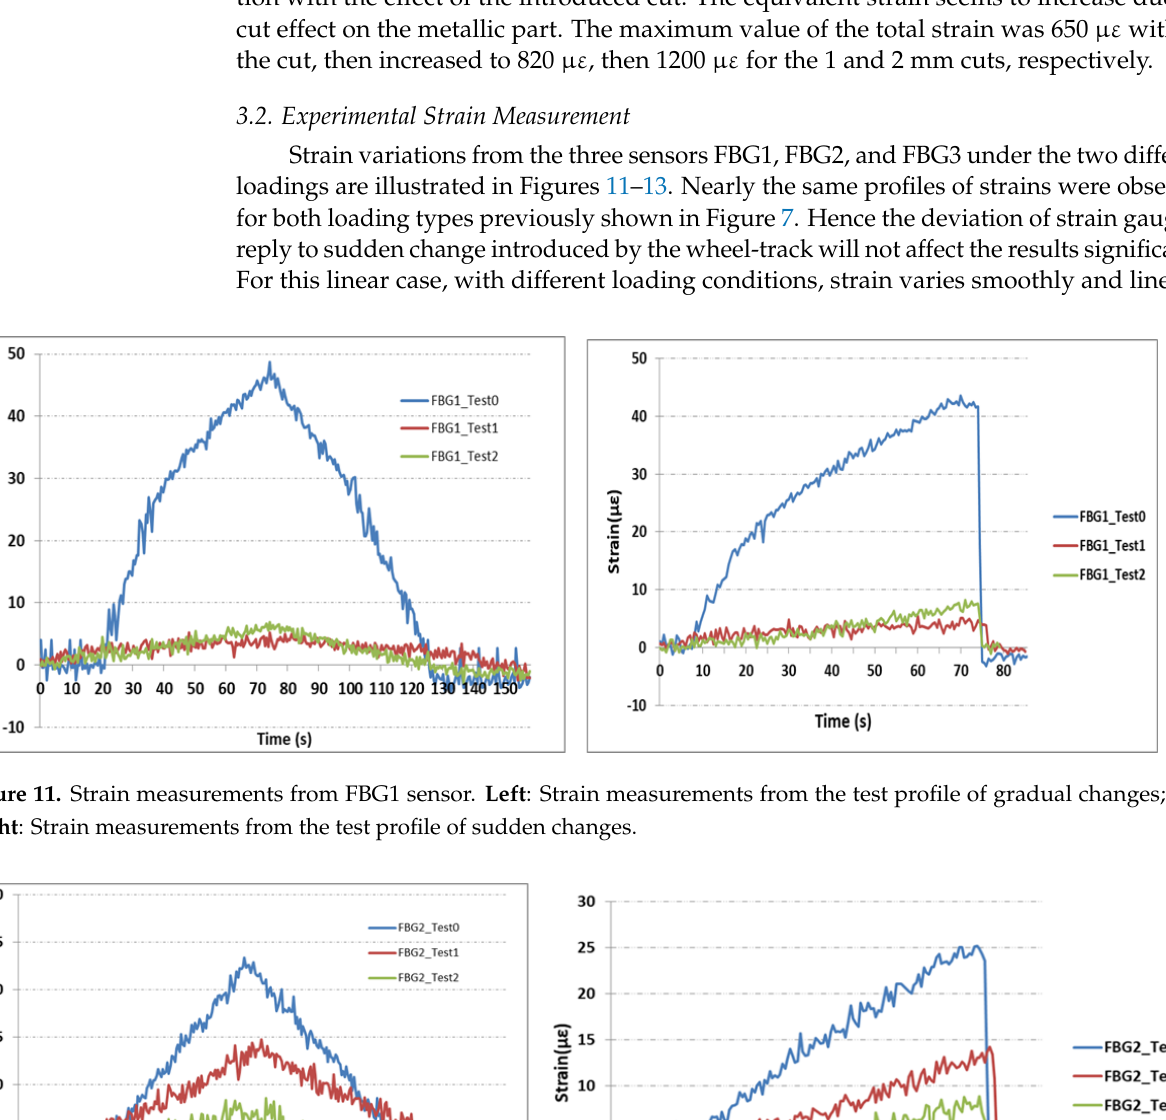
Figure 13. Strain measurements from the FBG3 sensor. Left : Strain measurements from the test profile of gradual changes; Right : Strain measurements from the test profile of sudden changes. 3.3. Comparison between Modeling and Experimental Strain Measurements Three points were selected from the 3D drawing schematic of the metallic part that roughly corresponded to the same position of the FBG sensors used for the experimental loading tests. Figure 14 illustrates the equivalent strain for the x -axis calculated for these points. Figure 14a, shows the strain calculation for the part without the cut. Figure 14a,b show the strain calculation for the 1 and 2 mm cuts, respectively. So, for example, the FBG1 has maximum values of 59.4, 34.7, and 32.6 με compared to the experimental maximum values of 48, 8, and 9 με .